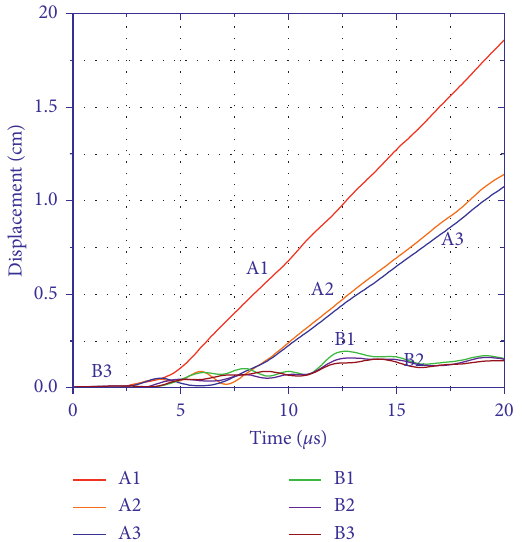
Figure 24: Joint displacement curve of no-slime-charge